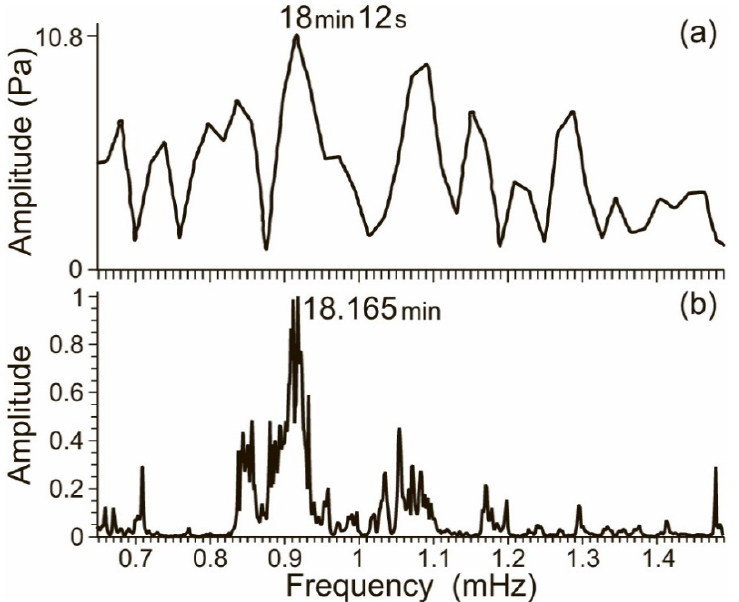
Figure 3. Spectrum of recording fragment of laser meter for hydrosphere pressure variations ( а ) and resonance curve ( b ). resonance curve ( b